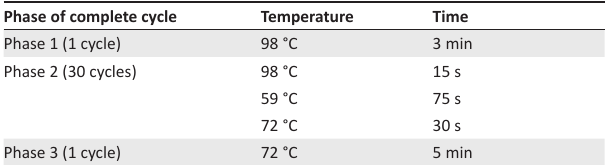
TABLE 1: PCR Cycle